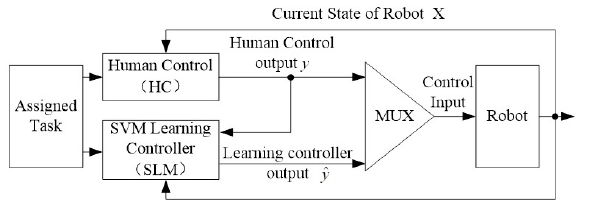
Fig. 4 Diagram for the learning control strategy.